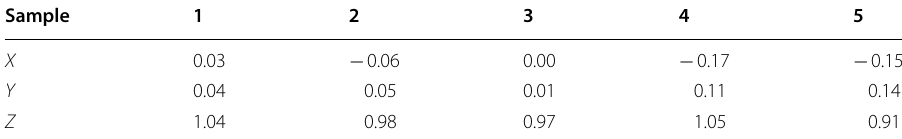
Table 1 Static data sample